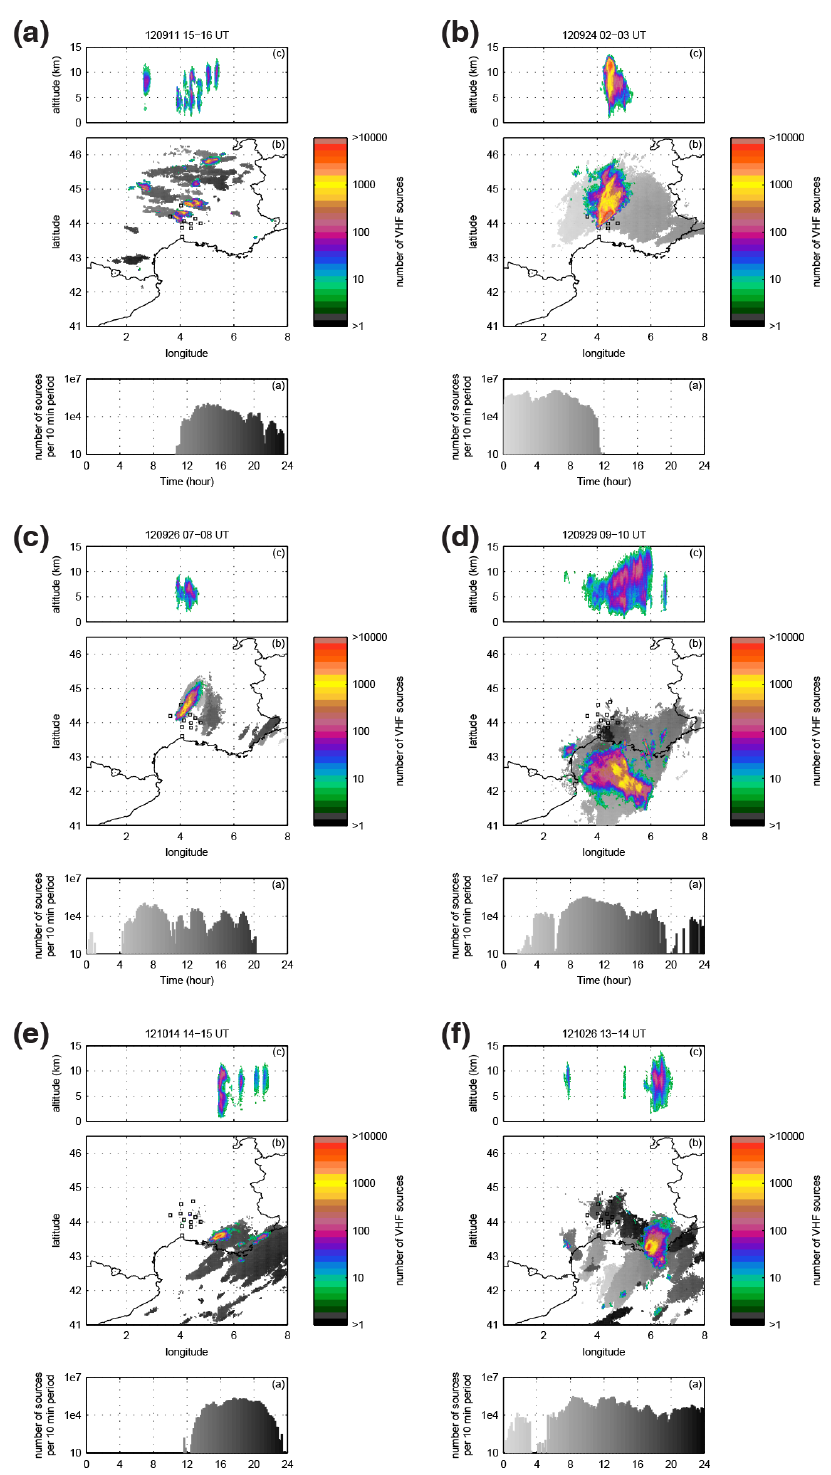
Figure 9. Total lightning activity recorded at different dates with HyLMA. (a) HyLMA VHF source rate per 10min period (plotted in decimal logarithmic scale); (b) ground projection of the HyLMA sources during 24h (in gray, from 00:00 to 23:59UTC) and density of HyLMA VHF sources during 1h computed per 0.025 ◦ × 0.025 ◦ grid (in color); (c) vertical distribution of the HyLMA VHF sources for the same 1h period (and indicated at the top of the panel) per 0.025 ◦ × 200m